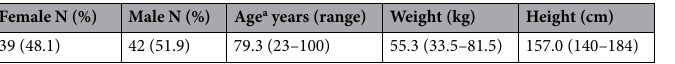
Branching pattern a (n =